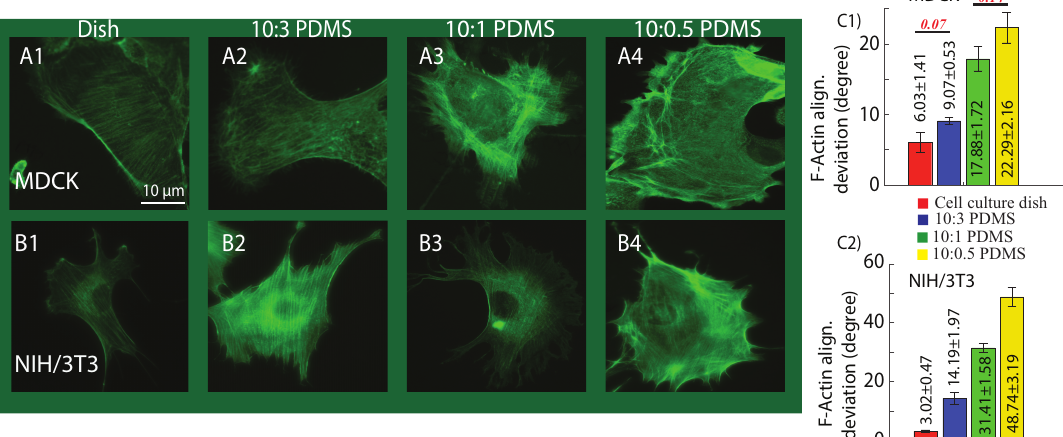
Figure 4. Examples of F-actin cytoskeleton images of ( A1 – A4 ) MDCK and ( B1 – B4 ) NIH/3T3 cells seeded on the four substrates, respectively. The cells were fixed and stained 24 hours after being seeded. Scale bar: 10 µ m. The F-actin alignment deviations for ( C1 ) MDCK and ( C2 ) NIH/3T3 cells seeded on each substrate. n = 6. Student’s t-test was performed to analyze the statistical difference: data for all substrates were compared to each other for each cell type. A p < 0.005 was yielded for each comparison unless otherwise denoted in the figure (with p values in red bold italic